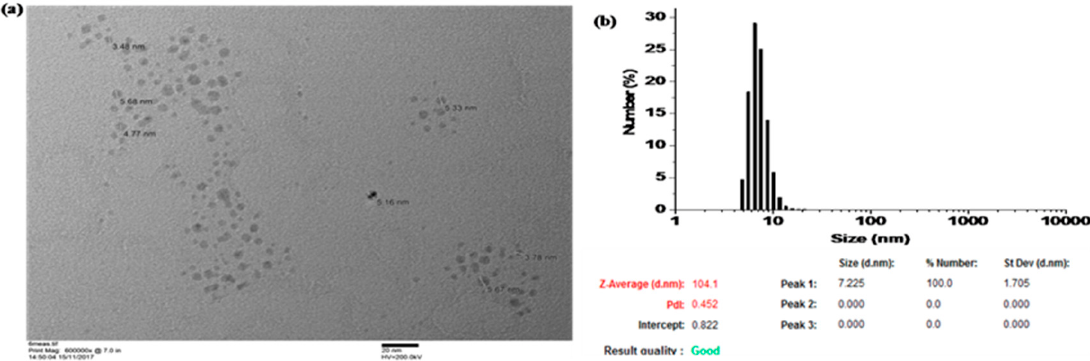
Figure 1. ( a ) TEM image of the solid AgNPs and ( b ) nanoparticle size distribution.